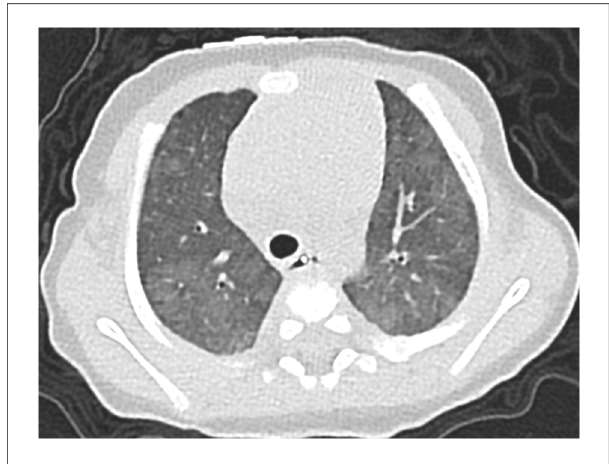
FIGURE 2 Case 1: axial CT images of lung window settings at 3 months. Axial CT images show heterogeneous ground-glass opacities in both lung fi